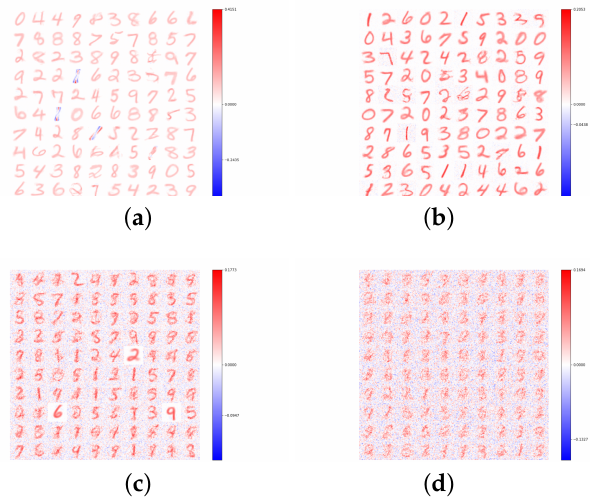
Figure 7. Shown are a hundred randomly selected feature detectors out of 2000 learned by the biologically plausible model for MNIST classification with different levels of added noise. ( a ) Original, no noise. ( b ) Gaussian noise, zero mean, 0.1 STD. ( c ) Gaussian noise, zero mean, 0.5 STD. ( d ) Gaussian noise, zero mean, 1.0 STD.